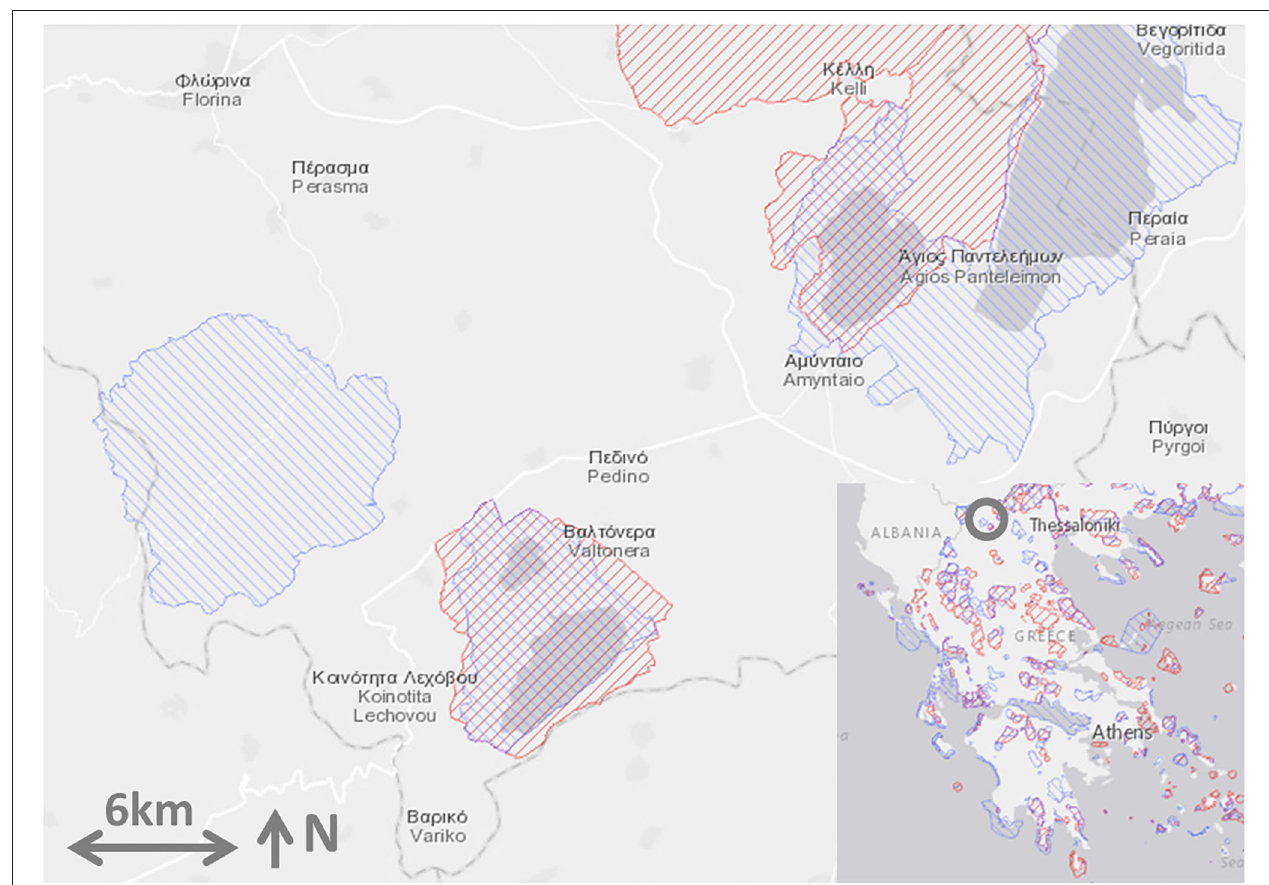
FIGURE 1 | The project area of LIFE AMYBEAR (Improving Human-Bear Coexistence Conditions in Municipality of Amyntaio–LIFE15 NAT/GR/001108) in a processed extract of the Natura 2000 Network Viewer (https://natura2000.eea.europa.eu/). Florina and Amyntaio are the main urban centers. The dashed areas are Natura 2000 sites. The site on the left is “Oros Vernon-Koryfi Vitsi” (Site Code: GR1340006), which contains core habitat for the brown bear ( Ursus arctos ).